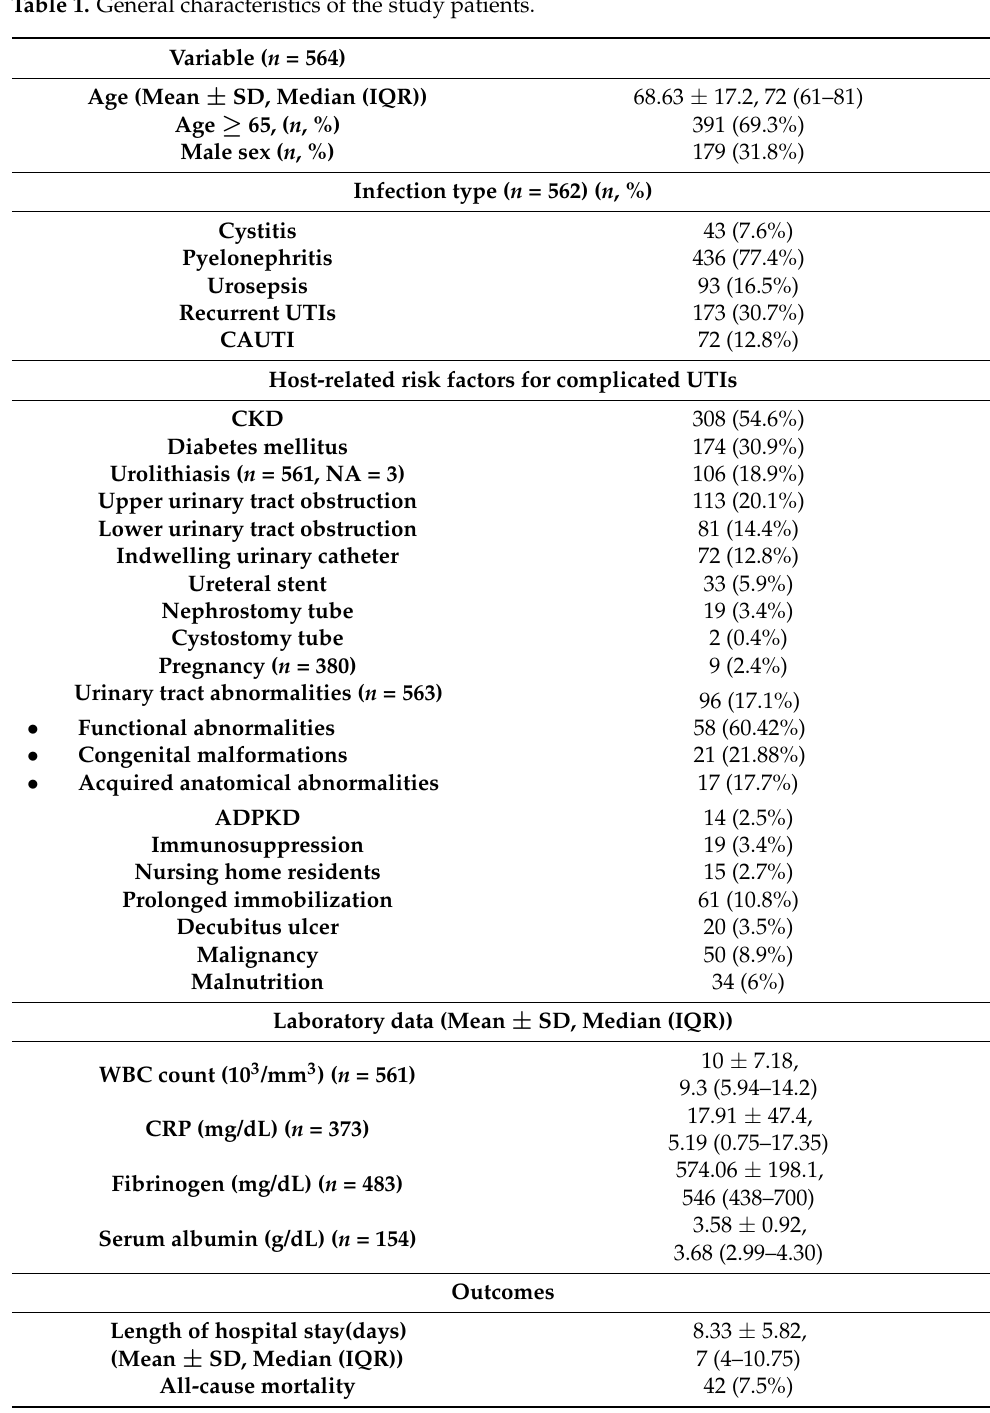
Table 1. General characteristics of the study